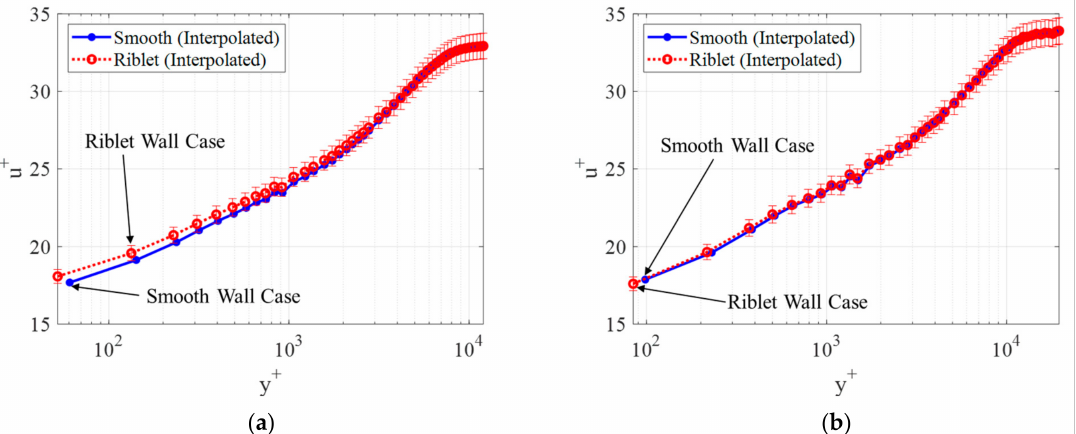
Figure 10. Comparison of boundary-layer profiles between smooth-wall and riblet-wall cases at ( a ) a near design point ( s + = 17) and ( b ) an off-design point ( s + =